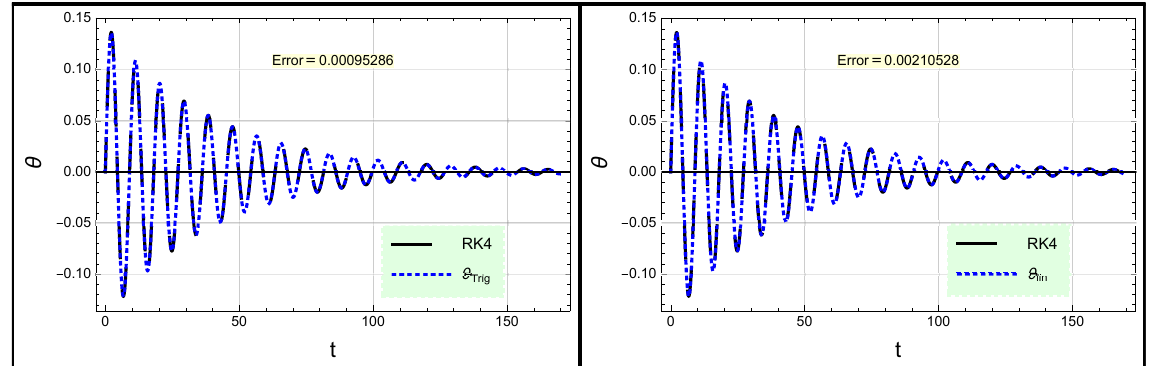
Figure 3. The approximation (22) to the non-conserved i.v.p. (21) and the exact solution (29) to the linearized i.v.p. (28) are compared with the RK4 numerical approximation to the i.v.p. (21) for